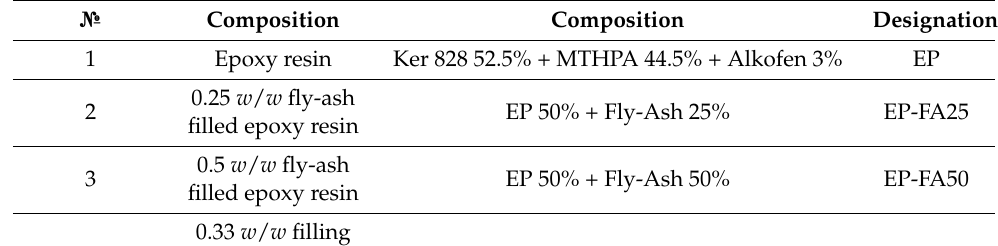
Figure 1. The fillers used: ( a ) Fly ash from the SDPP; ( b ) Backfill material obtained from the mineral processing waste of the copper-mining plant.